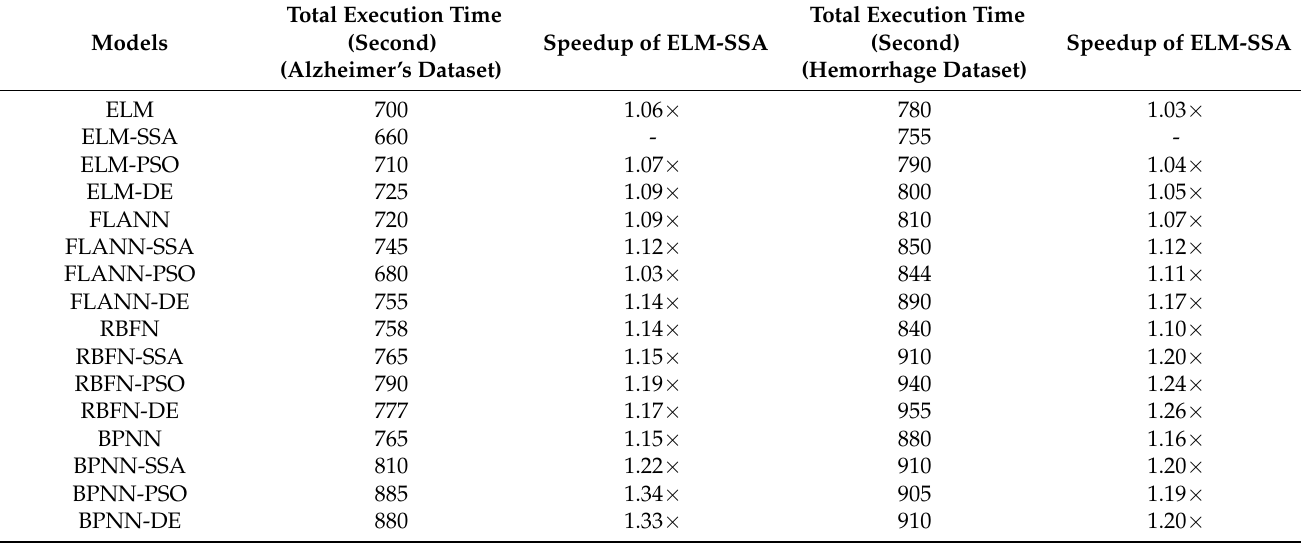
Table 8. Comparison of average execution time of proposed ELM-SSA model with other classification models.